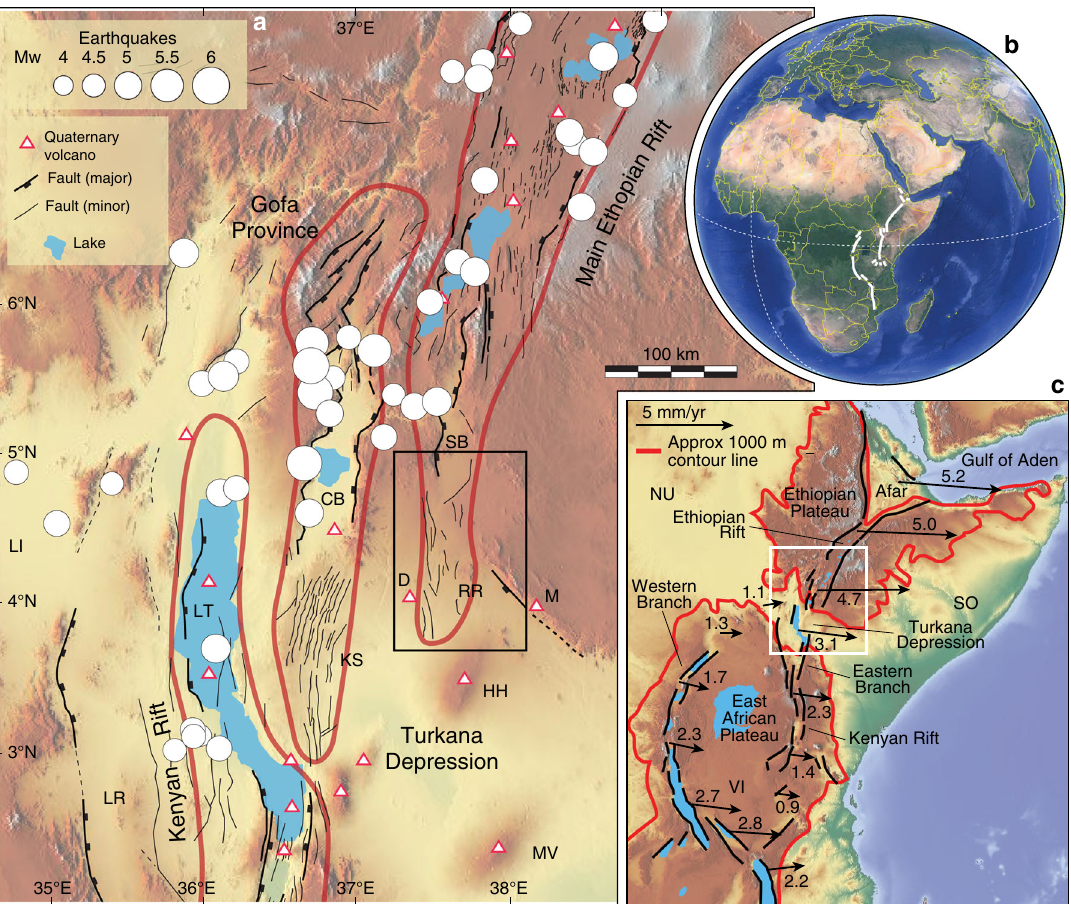
Fig. 1 Tectonic setting of the Turkana depression. a Quaternary faults, seismicity and Quaternary volcanoes in the Turkana depression and surrounding regions superimposed on a SRTM (NASA Shuttle Radar Topography Mission) digital elevation model (modi fi ed from ref. 17 ). Seismicity from USGS National Earthquake Information Center (NEIC) catalogue (https://earthquake.usgs.gov/earthquakes/search/); Quaternary volcanoes from the Smithsonian Institution, Global Volcanism Program 62 (http://volcano.si.edu/). Red lines delineate the deformation domains of the Kenyan rift, Kino Sogo fault belt (KS)-Gofa Province, and Main Ethiopian rift 13, 15 . Black square indicates the area illustrated in Fig. 2. CB: Chew Bahir basin; D: Dilo-Dukana volcanic fi eld; HH: Hurri Hills; LI: Lokitipi basin; LT: Lake Turkana; LR: Lokichar basin; M: Mega volcanic fi eld; MV: Marsabit volcano; SB: Segen basin; RR: Ririba rift. b Location of the East African rift (white lines); c schematic fault pattern and present-day plate kinematics. Black arrows show relative motions with respect to a stable Nubian reference frame according to the best- fi t model of ref. 12 . Values besides arrows indicate motion in mm per year. White square indicates the area portrayed in panel a . NU: Nubian plate; SO: Somalian plate; VI: Victoria